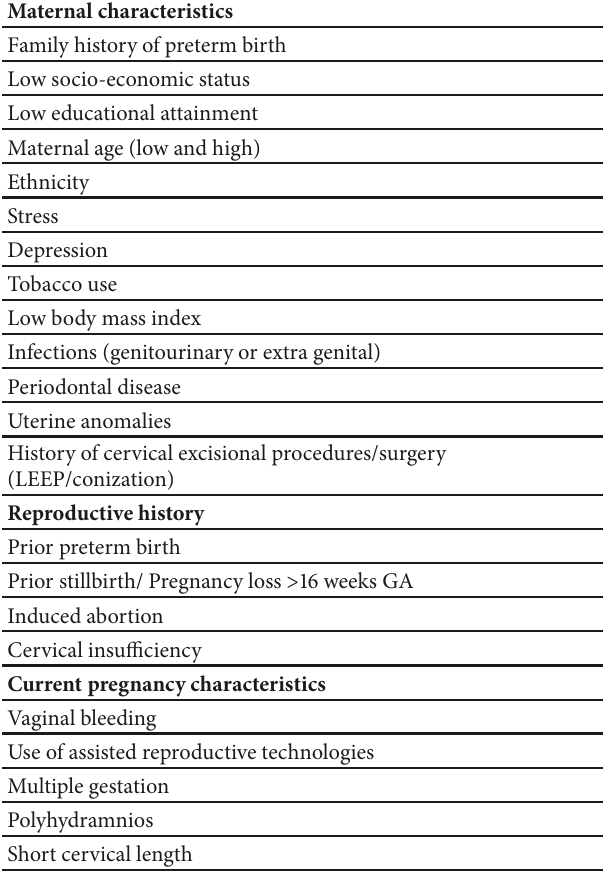
Table 1: Risk factors for preterm birth (adopted from Koulali and Frey) [5,